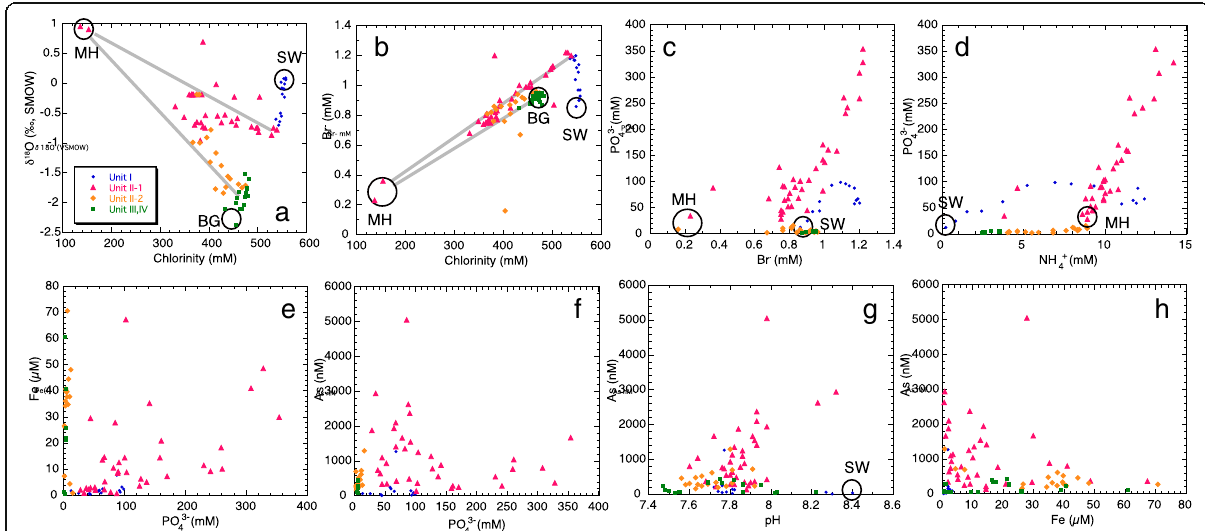
Fig. 7 Relationships of total As and δ 18 O and dissolved chemical components in IW sensitive to changing redox condition a : chlorinity and δ 18 O; b : chrolinity and Br - concentration; c : Br - and PO 43- concentrations; d : NH 4+ and PO 43- e : PO 43- and Fe; f : PO 43- and As; g : pH and As; Fe and As. SW, MH, and BG are the seawater, dissolved water from methane hydrate, and diagenetically altered interstitial water, respectively ( a referred Toki et al. (2017) was modified). Data except As concentrations were from Moore et al. (2013) and Toki et al.